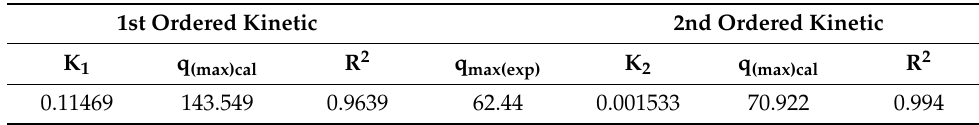
Figure 8. ( A ) Pseudo first-orders and ( B ) Pseudo second-order kinetics models of the adsorption of Cr(VI) upon TIHP at 25 °C; pH 2, T = 25 ± 1 °C and 250 mg/L initial concentration. Table 2. Kinetic factors controlling Cr(VI) adsorption upon